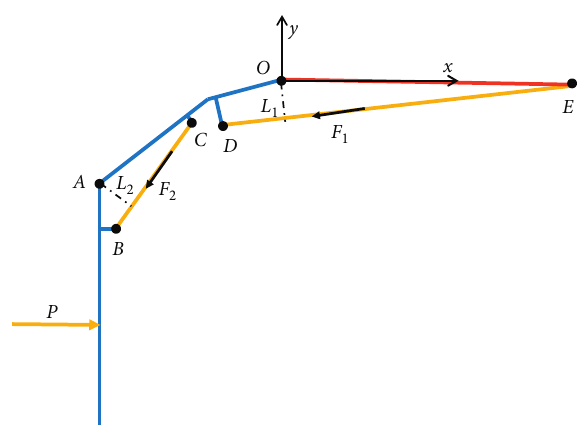
Figure 9: Stress analysis diagram of the split face